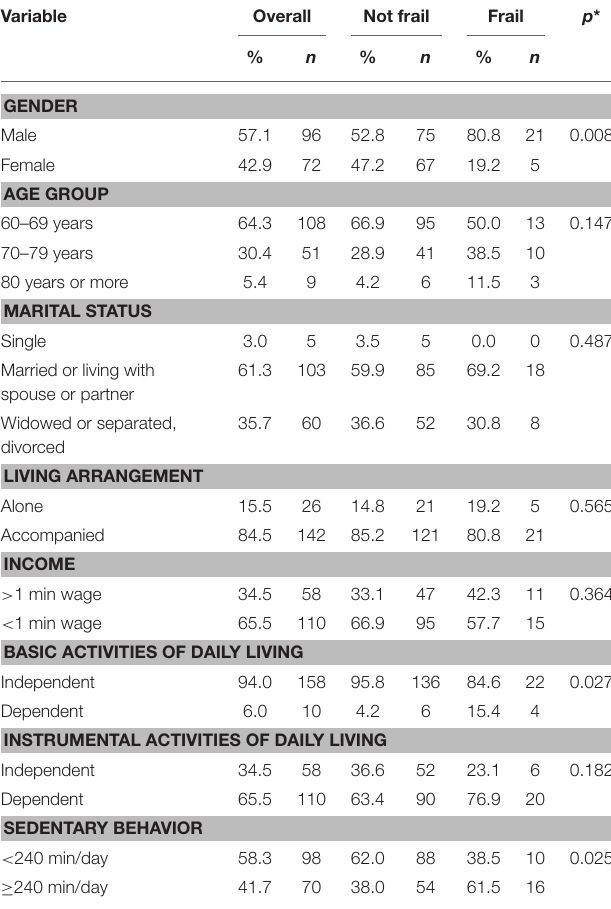
TABLE 1 | Distribution of social and economic variables, functional disability, and sedentary behavior in the sample of older inpatients.